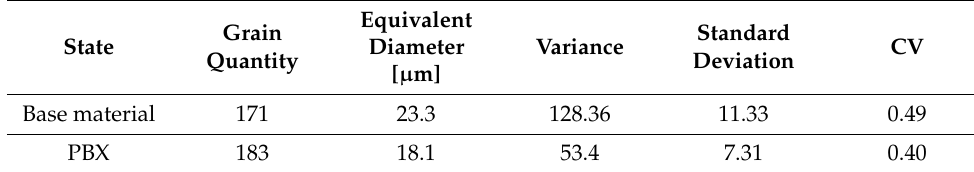
Table 4. Results of the quantitative analysis of the